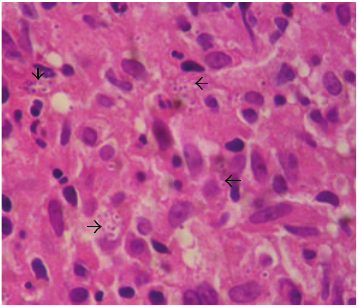
Figure 4: H&E 80x. Arrows showing intra- and extracellular small yeast of Histoplasma capsulatum .